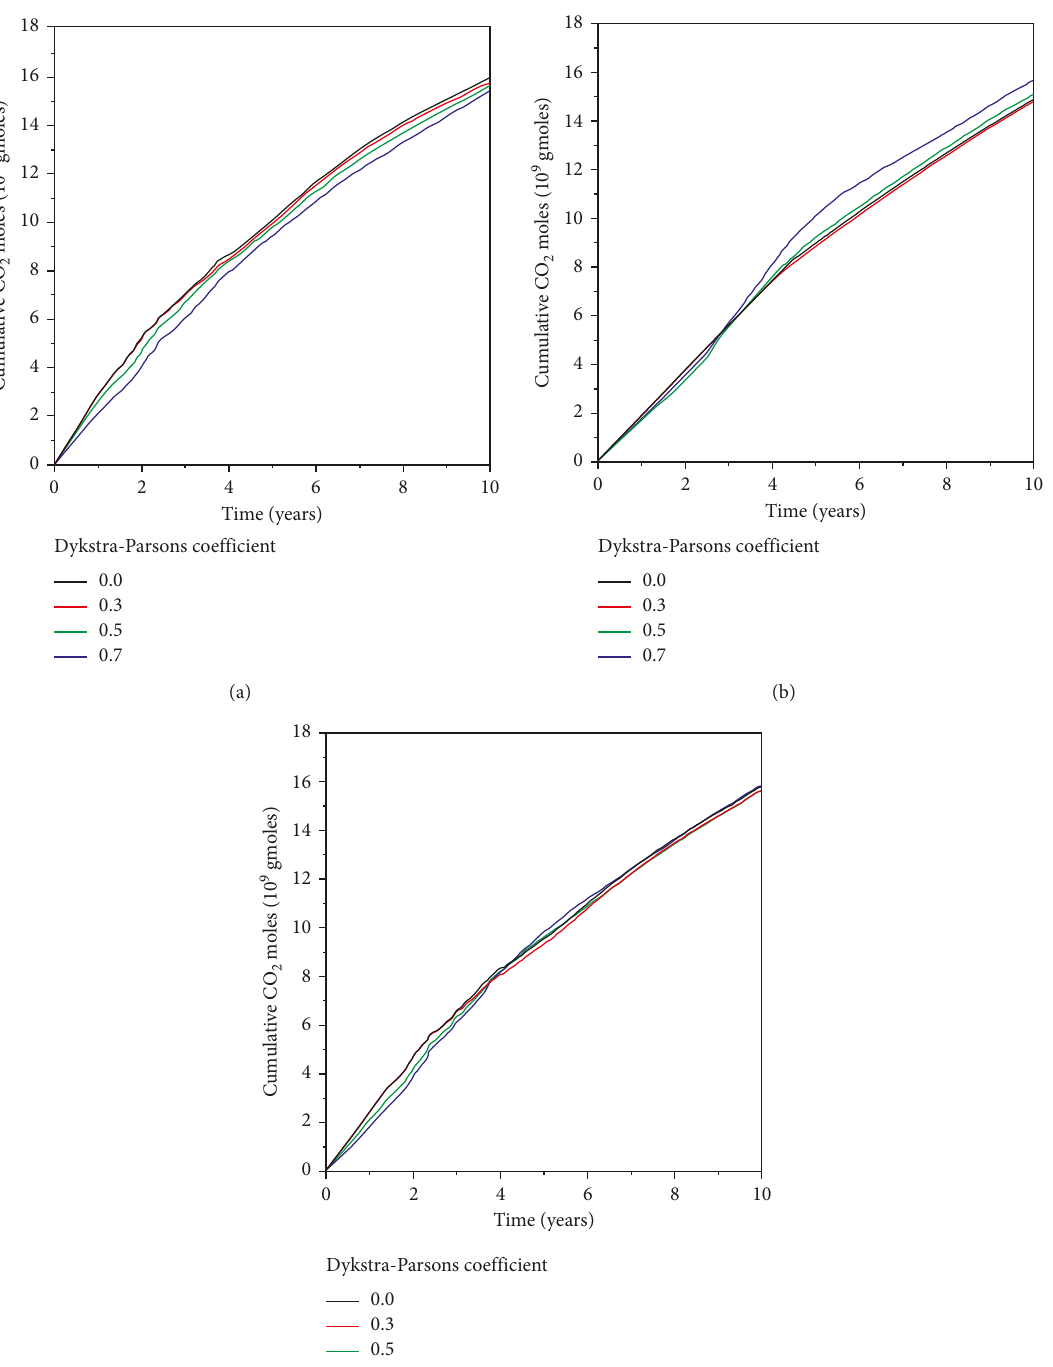
Figure 6: Cumulative in-place amounts of CO 2 in aquifer at different times: Cases A, B, and